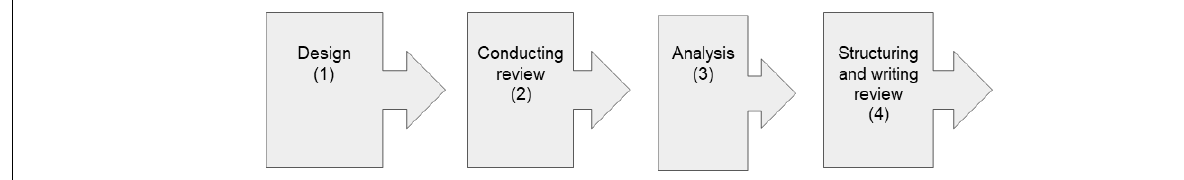
Figure 1: Literature review process based on Snyder 29 .